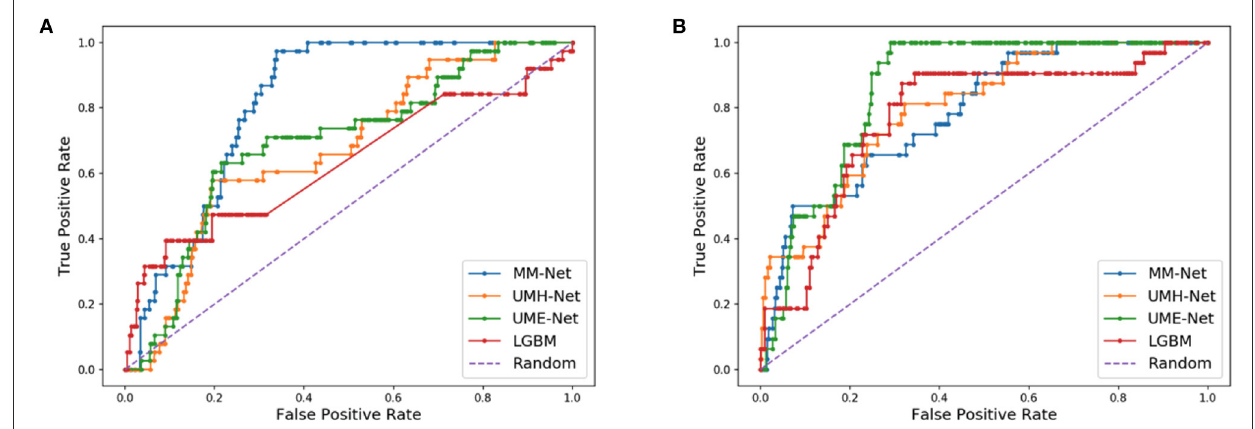
FIGURE7 Receiver operating characteristic (ROC) curves for two different data splits. (A) MM-Net outperforms the baseline models. (B) MM-Net underperforms the baseline models.